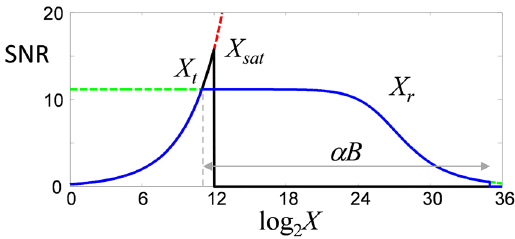
Figure 3. Analysis of signal to noise ratio (SNR) as a function of sample strength X . Black trace is SNR for conventional two-photon microscopy ( α = 2), limited to sample strength X sat at which point the detector saturates, for acquisition bit depth B = 12. Red and green dashed traces are SNR for power-limited and feedback-active modes respectively – transition between the two modes occurs at X t . Net AI SNR (blue trace) is shot-noise limited up to sample strength X r , at which point it begins to roll off when the laser power P falls below detector noise or becomes undersampled. Signal set point S 0 is set here to half the detector saturation level. The maximum allowed laser power P max is set to P 0 . S sat is taken to be 250 (see Supplementary Information). Note that conventional microscopy leads to higher SNR only for a small range of sample strengths. This range can be reduced by increasing S 0